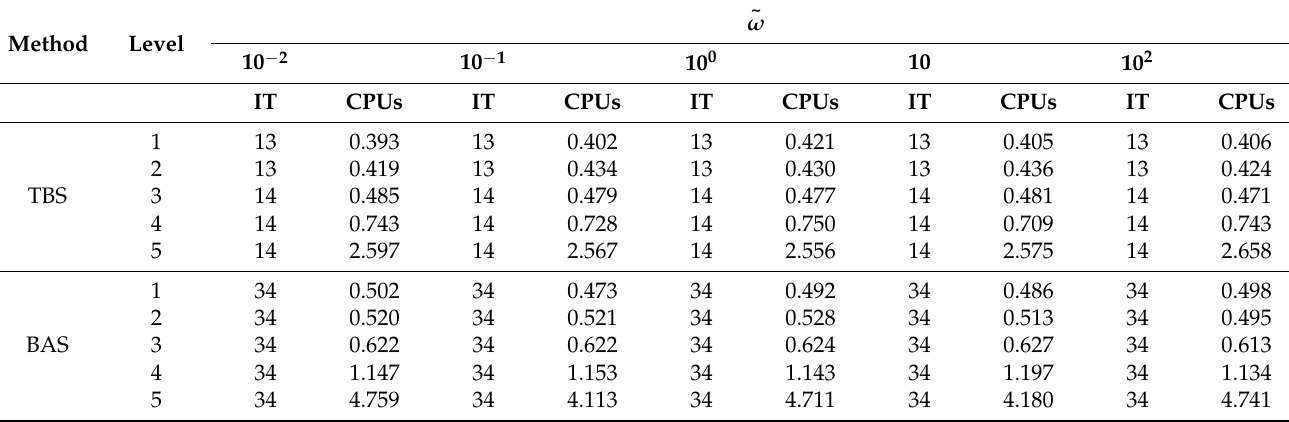
Table 3. Different mesh refinement levels and (cid:101) ω , the results of iteration method in the 2D case, with ε = 10 − 4 . Method Level